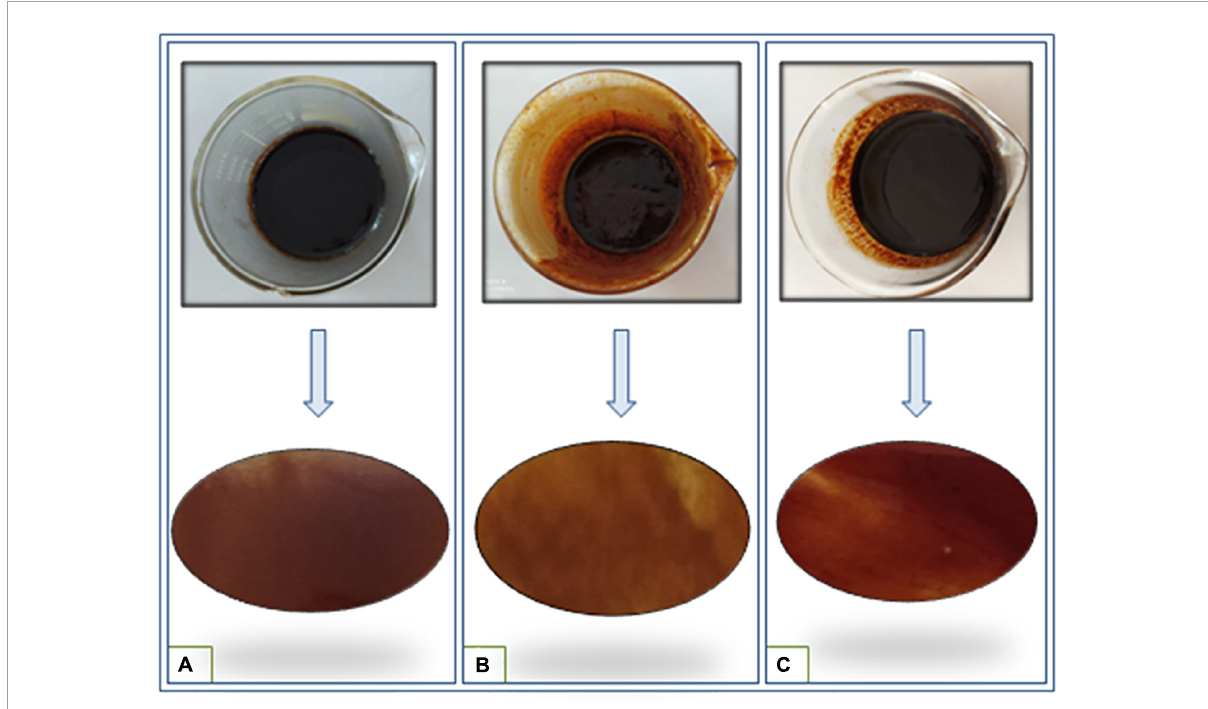
FIGURE1 Color variation of different root extracts of Skimmia anquetilia (A) n -hexane extract, (B) ethyl acetate extract, and (C) methanol extract.